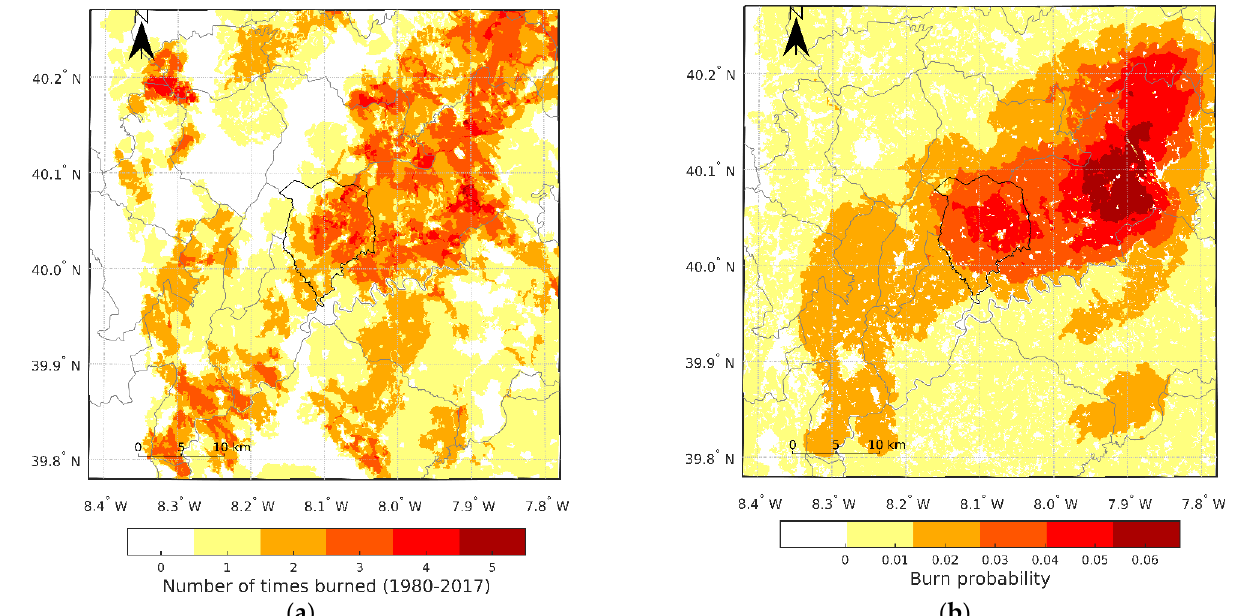
Figure 2. Spatial distribution of ( a ) observed frequency of very large wildfires (>1000 ha) between 1980 and 2017 and ( b ) predicted burn probability. Gray lines represent municipalities; black lines represent the Alvares parish boundary.